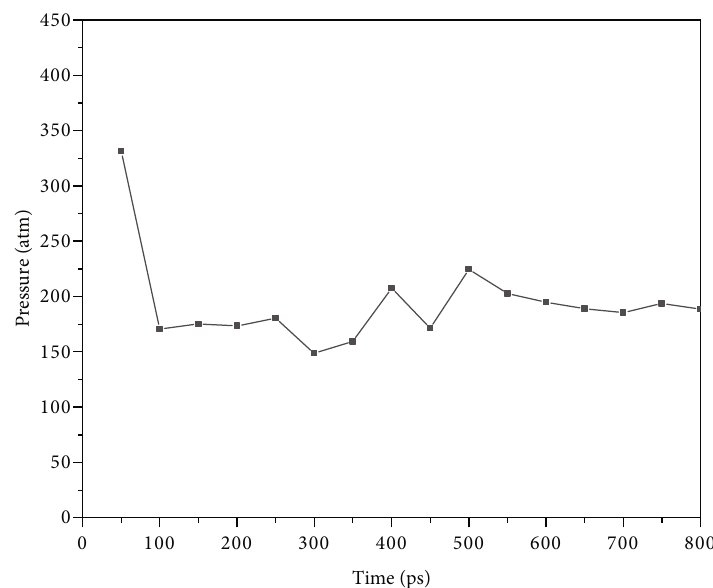
Figure 2: Total pressure during NVT relaxation.